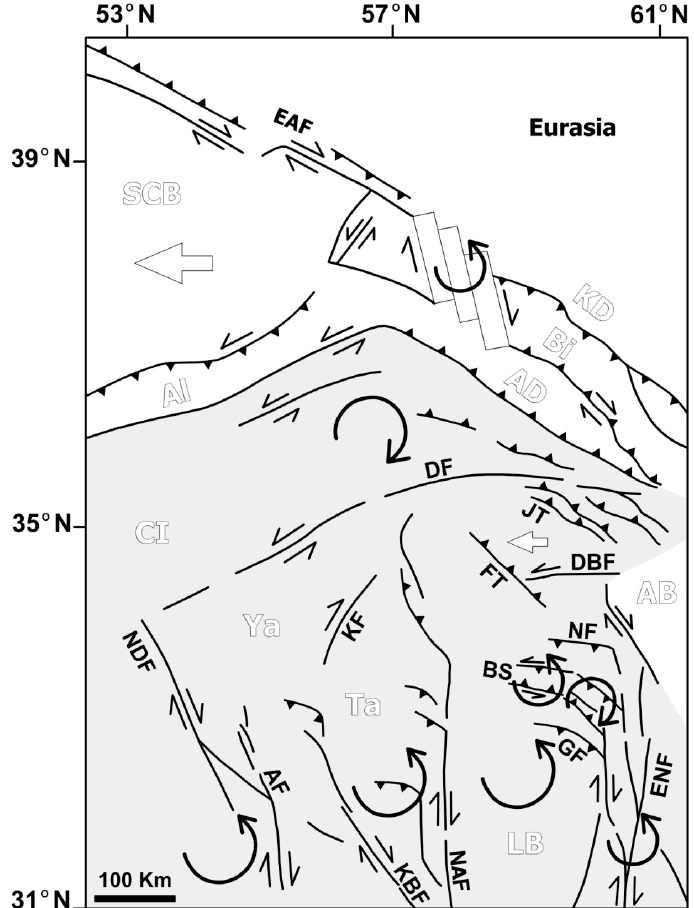
Figure 20. The suggested kinematic model for the north of central and eastern Iran. Details in the text. Abbreviations: EAF = Eshgh-Abad fault; DF = Doruneh fault; JT = Jangal fault; DBF = Dasht-e Bayaz fault; FT = Ferdows thrust; NF = Nowzad fault; GF = Give fault; ENF = East Neh fault; KF = Kalmard fault; NAF = Nayband fault; KBF = Kuhbanan fault; AF = Anar fault; NDF = Naein-Dehshir fault; SCB = South Caspian Basin; KD = Kopeh-Dagh zone; Bi = Binalud zone; AD = Ala-Dagh zone; Al = Alborz zone; Cl = central Iran zone; Ya = Yazd block; Tabas block; LB = Lut block; AB = Afghan block; BS = Birjand splay.